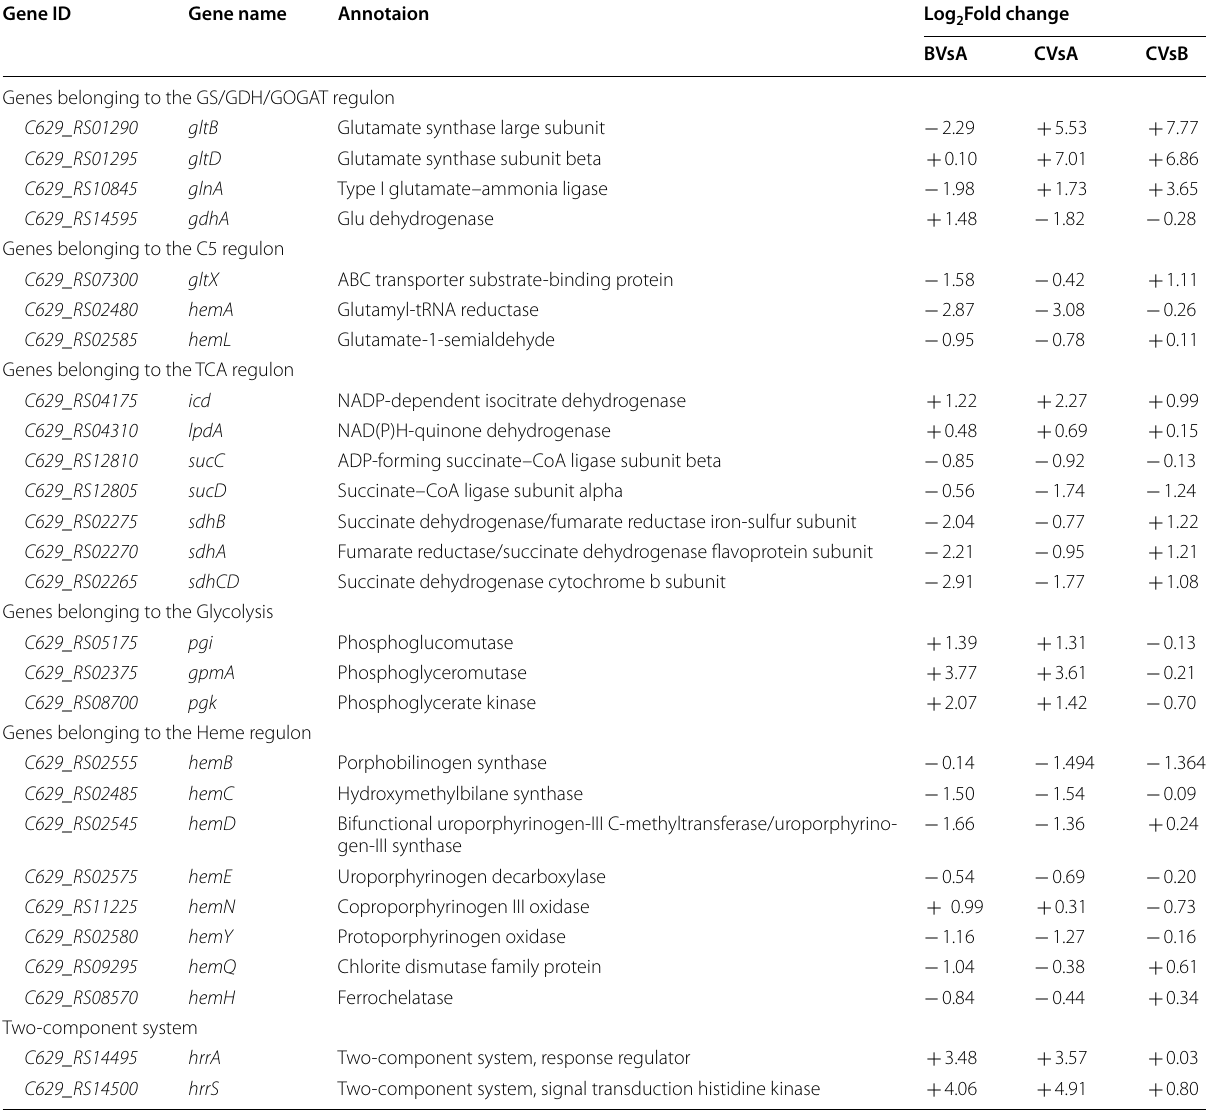
A: C. glutamicum /pXMJ19 (F1-P); B: C. glutamicum /pXMJ19- hemA C4 (F1-A); C: C. glutamicum ∆ gdhA / pXMJ19- hemA C4 (F2-A)